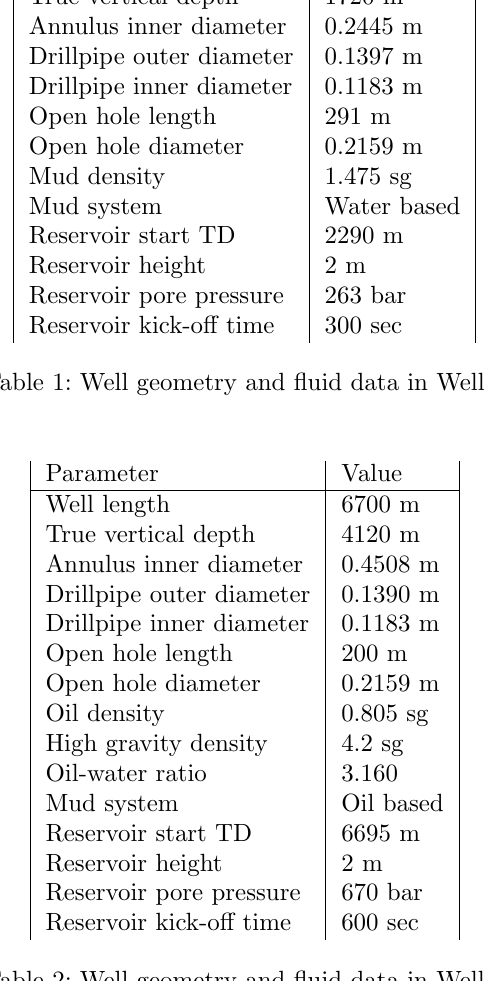
Table 2: Well geometry and fluid data in Well